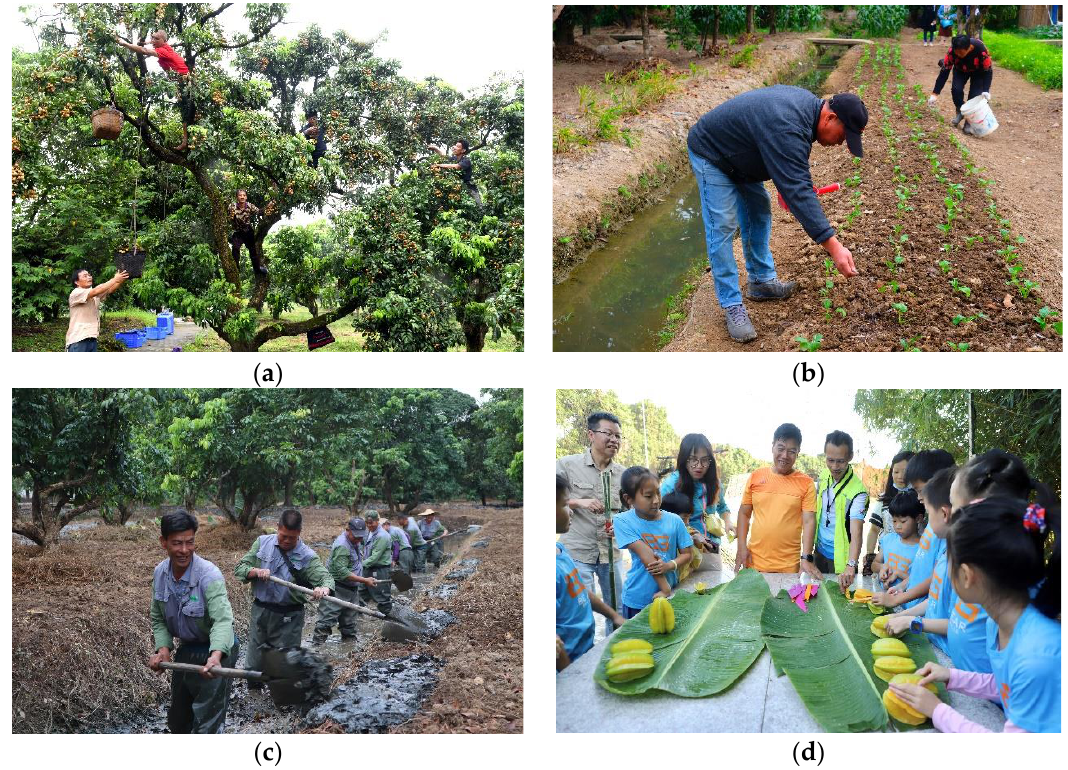
Figure 5. Farmers employed by the WCMO: ( a ) Fruit tree cultivation (Credit: Huiqiang Xie); ( b ) Vegetable cultivation; ( c ) Dredging ditch mud (Credit: Huiqiang Xie); ( d ) Farming culture education (Credit: Huiqiang Xie).